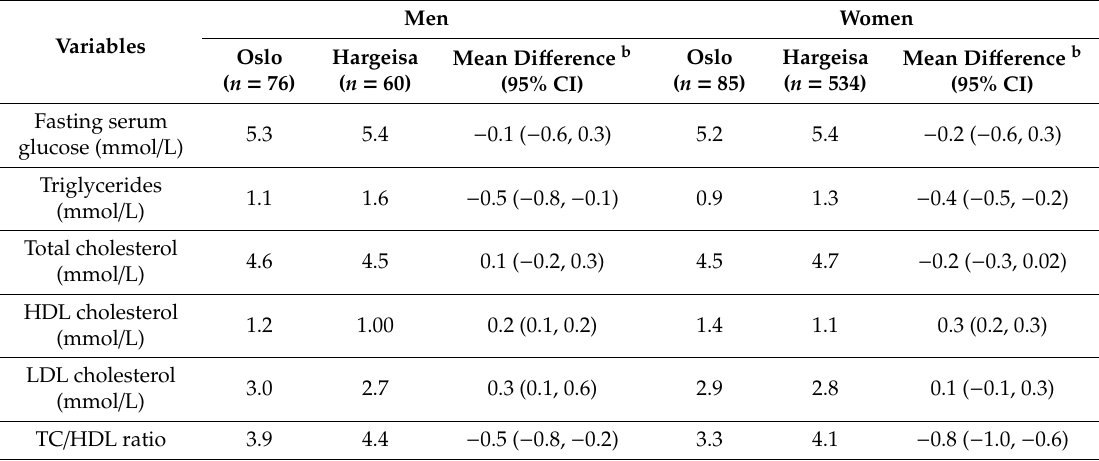
Table 2. Mean serum lipids (mmol / L) by location and gender adjusted for age a . Men Variables